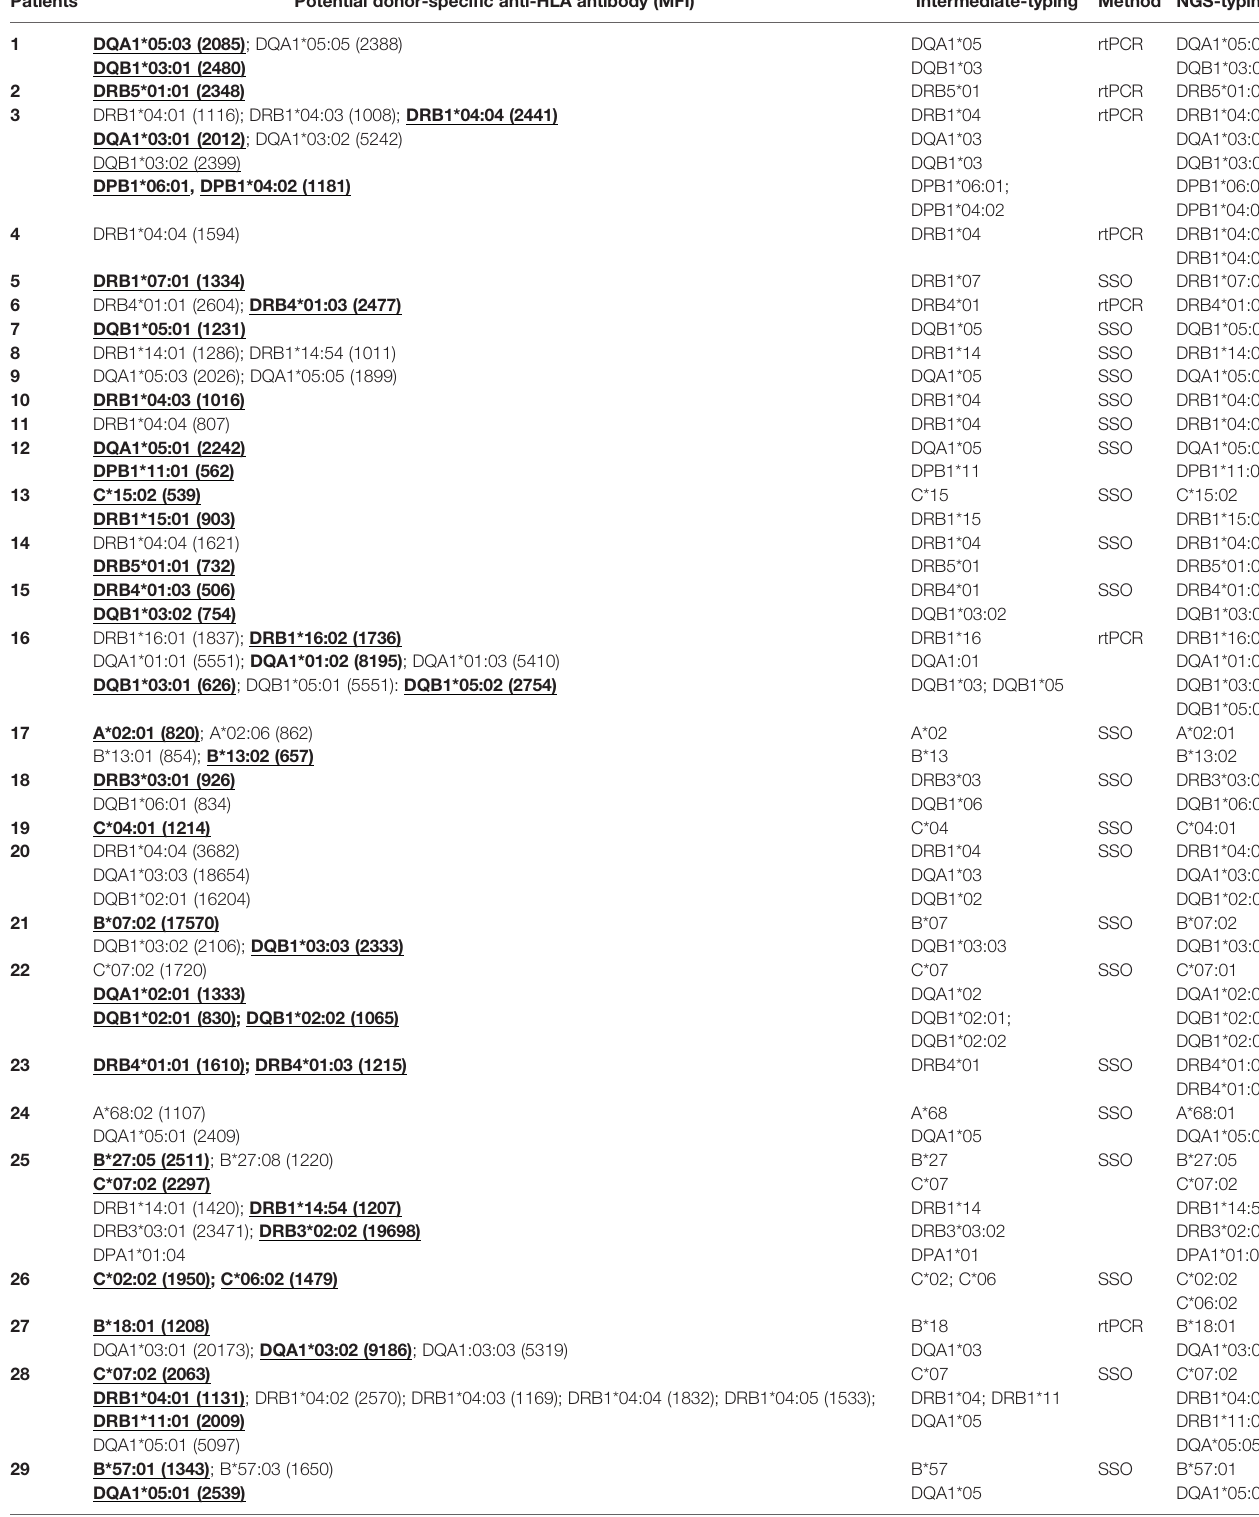
TABLE 3 | The assignment of actual pre-transplant donor-speci fi c anti-human leukocyte antigen antibodies according to intermediate resolution donor typing at time of donor kidney allocation. Patients Potential donor-speci fi c anti-HLA antibody (MFI) Intermediate-typing Method